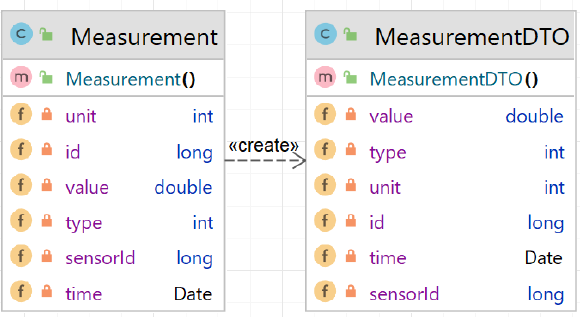
Figure 8. Measurement class and corresponding transport